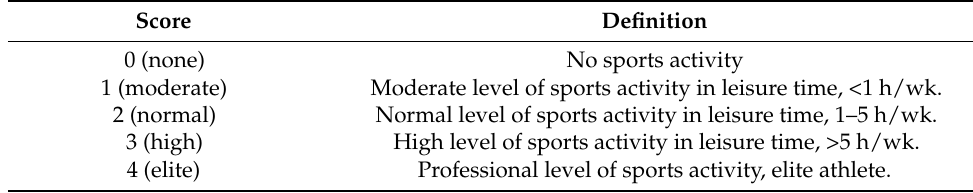
Table 1. Sports Frequency Score [29].